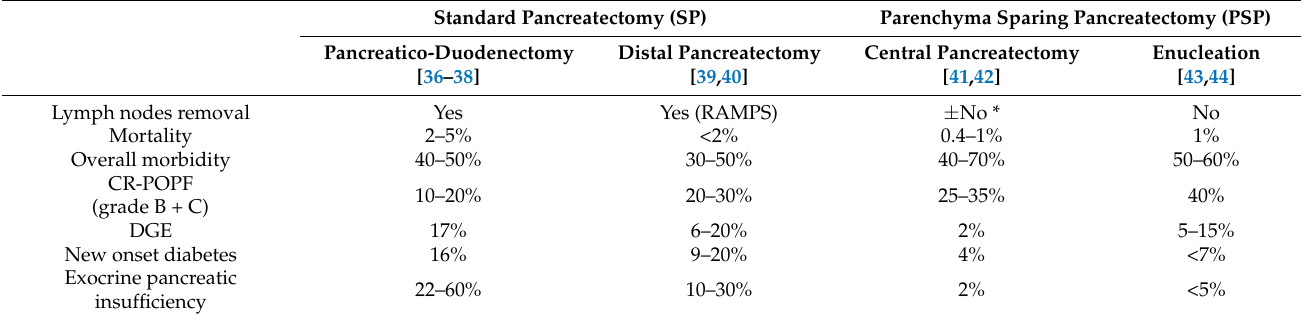
Table 3. Elements to differentiate surgical